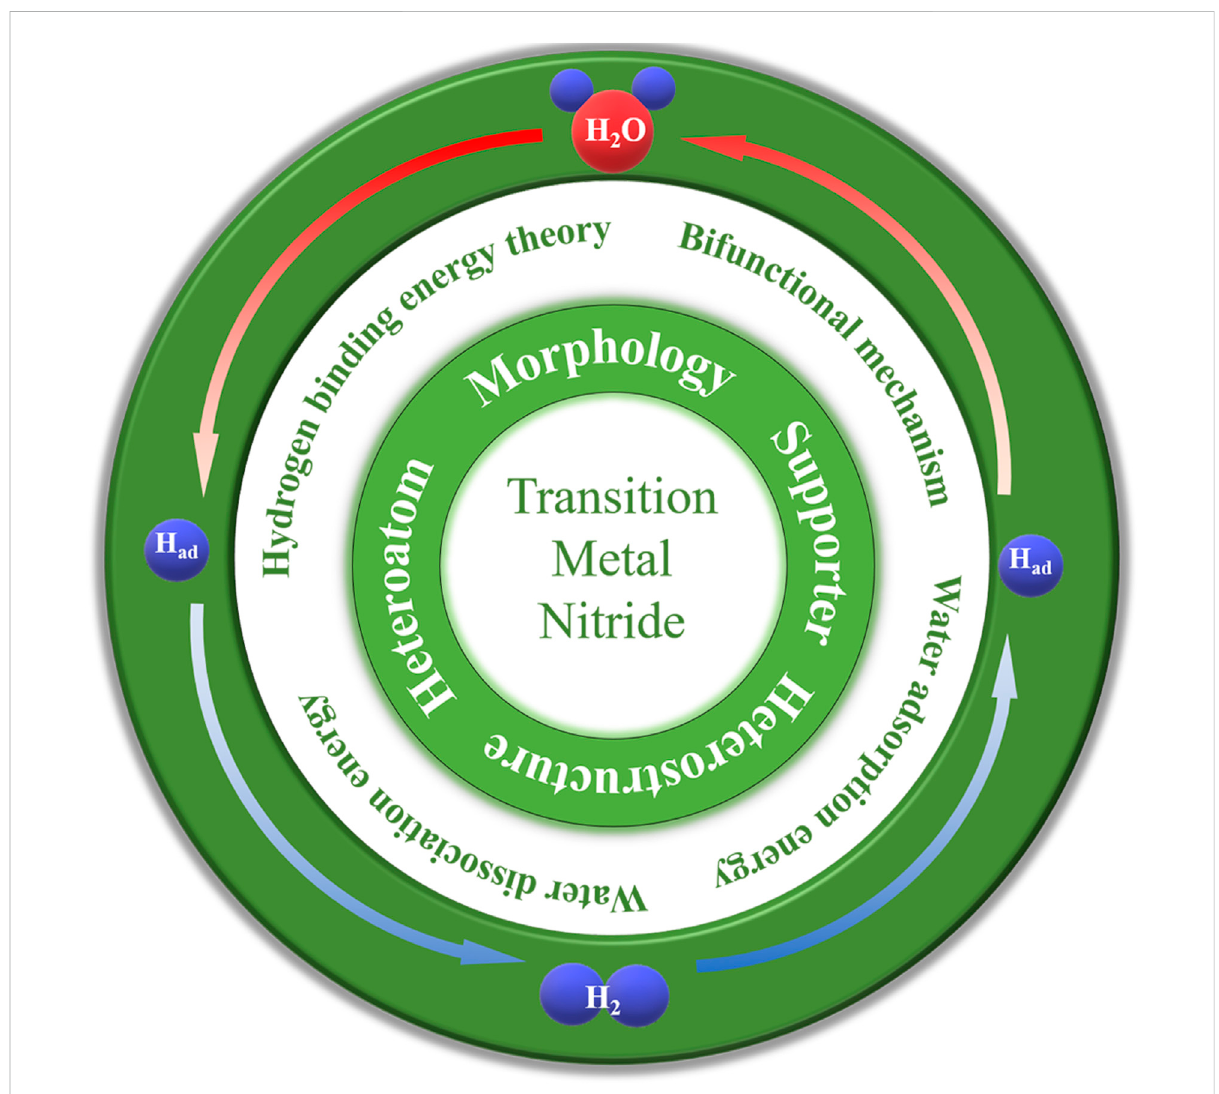
FIGURE 1 Transition metal nitrides for alkaline